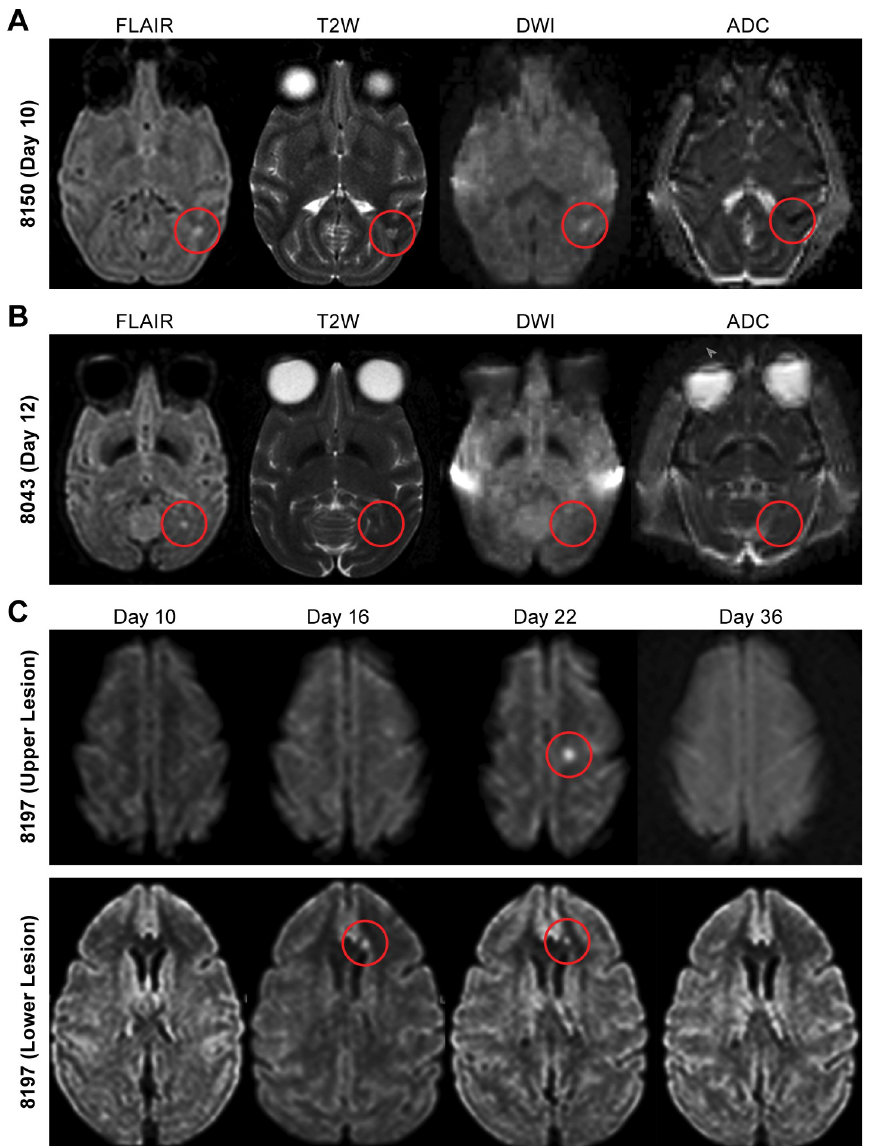
Fig 3. Demonstration of NiV-induced lesion in the brain of AGM. Magnetic resonance imaging (MRI) was performed prior to and at multiple time points following NiV-exposure. (A) MRI scans from animal #8150 obtained at day 10 PI. A small focal area of increased signal intensity is seen in the left temporal subcortical white matter on FLAIR and T2 weighted (T2W) images. This corresponded to increased signal on DWI and decreased signal on ADC (restricted diffusion) suggestive of acute/subacute ischemic focus. (B) similar sequences obtained in animal 8043 at day 12 PI show a small hyperintense focus in the left occipital subcortical white matter on T2 and FLAIR images, however with no evidence of restricted diffusion. (C) FLAIR images obtained on days 10, 16, 22 and 36 PI in animal 8197 show focal hyperintensity in the left centrum semiovale, appearing on Day 22 (upper panel) and another focal hyperintensity in the left frontal periventricular white matter, appearing on day 16 (lower panel). Along with a third similar lesion in the left occipital region that is not visible in these slices, none of the lesions was associated with restricted diffusion or enhancement and all three lesions resolved by day 36